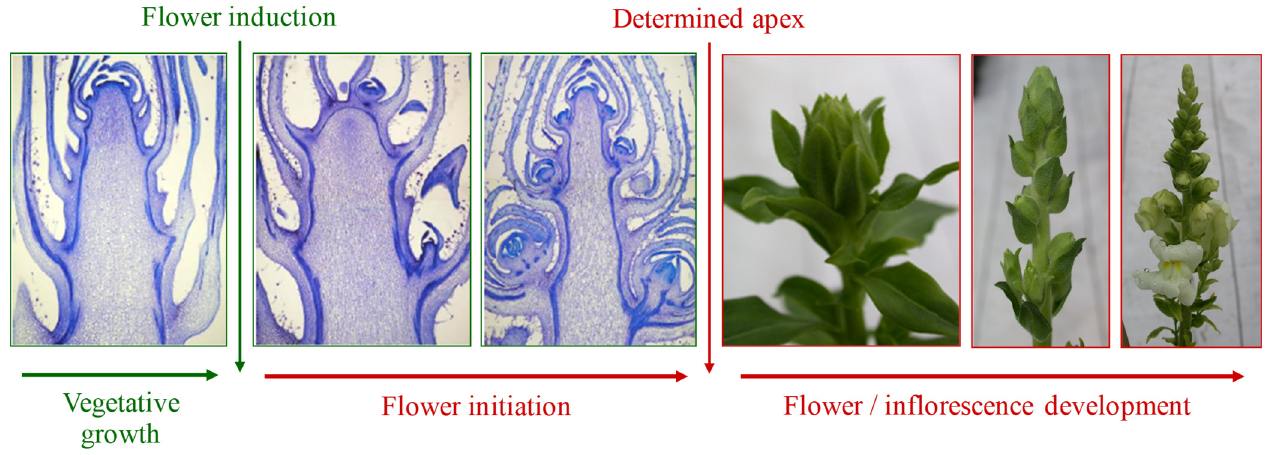
Figure 1. Subsequent phases of the development of the apical meristem and inflorescence in snap- dragon ( Antirrhinum majus L.). Credit : Roberta Paradiso.